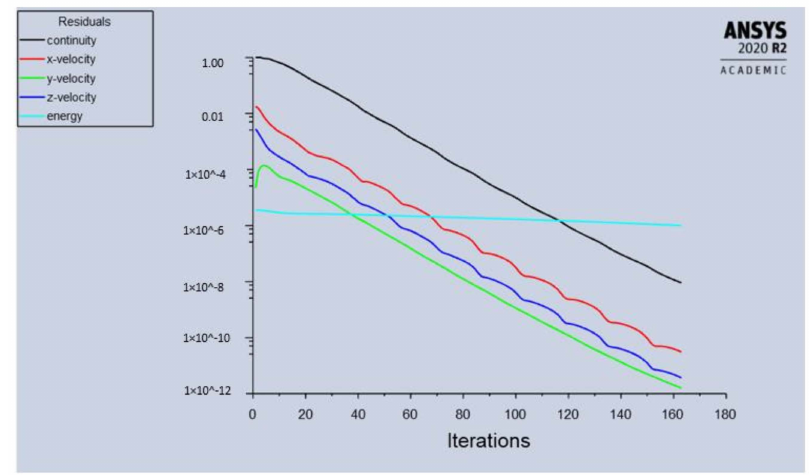
Figure 7. Converged residual plot for Design 2.